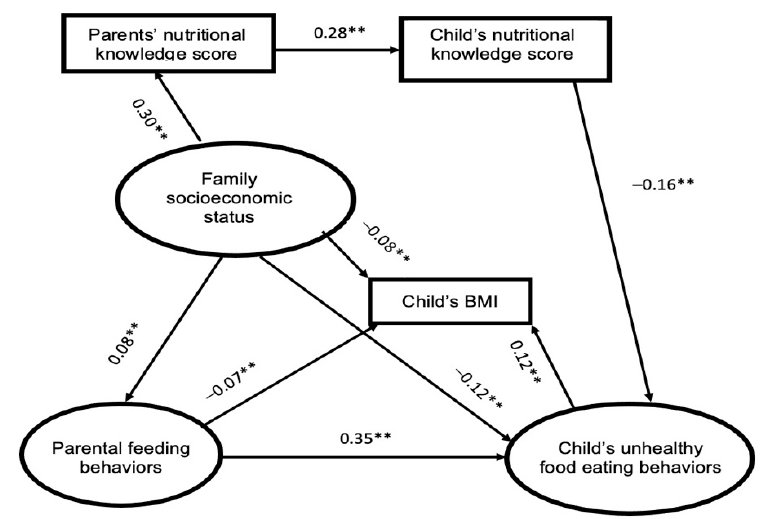
Figure 2. Model A (the solid line represents statistically significant values. ** p < 0.0001).